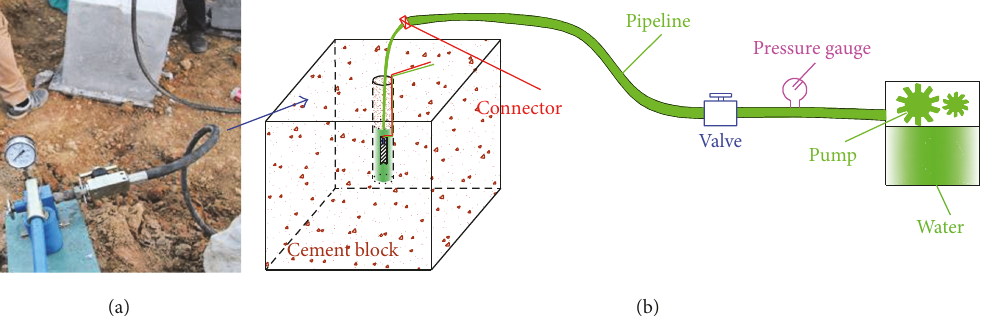
Figure 4: Operations in (a) connecting tubes and wires and (b) loading explosive and sealing